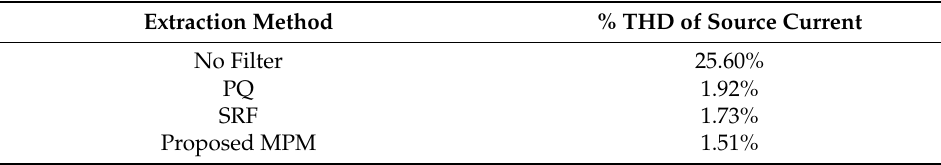
Figure 12. FFT analyzer considering delays for source current ( a ) with APF using SRF extraction ( b ) with APF using MPM extraction. Table 3. Source Current % THD comparison including delays.